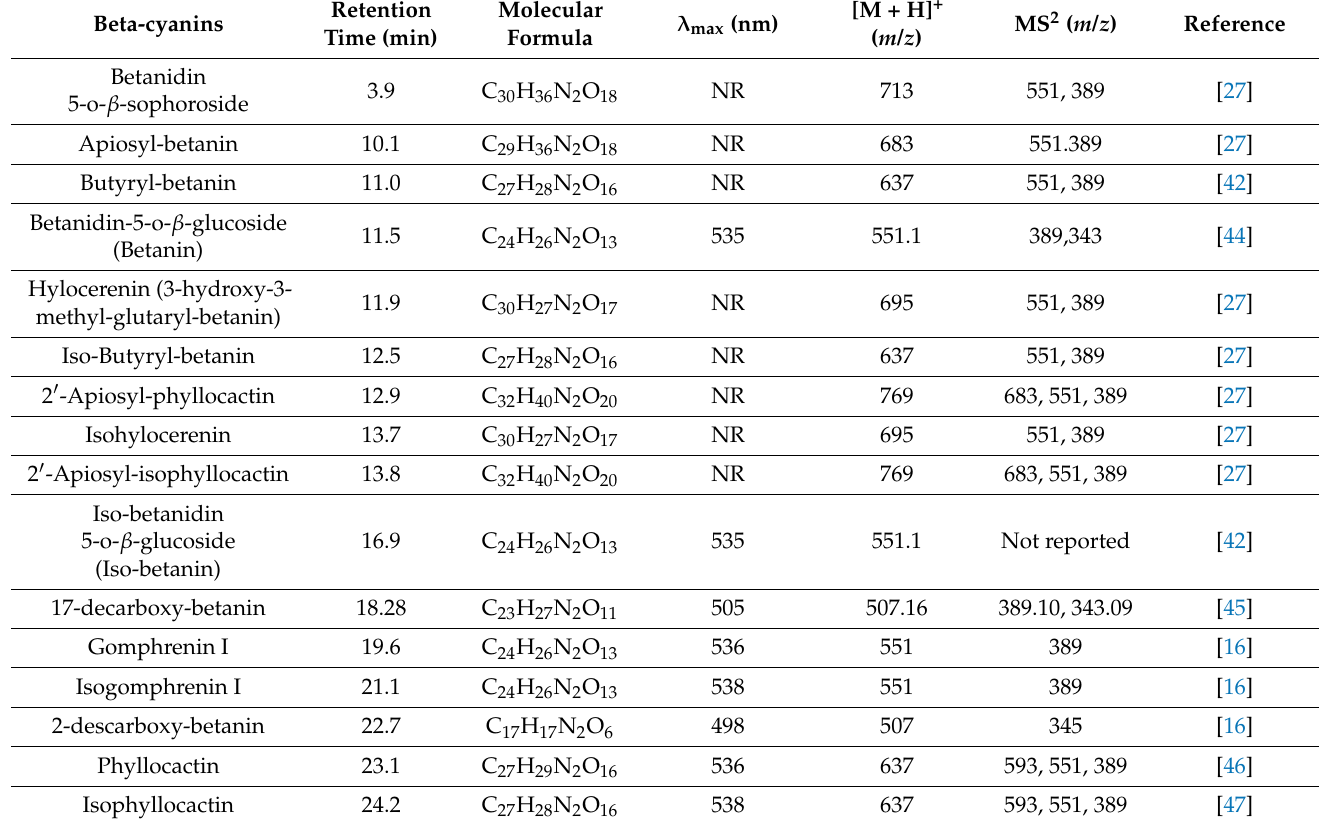
Table 3. LC-MS data for peak identification of betalains in red pitaya